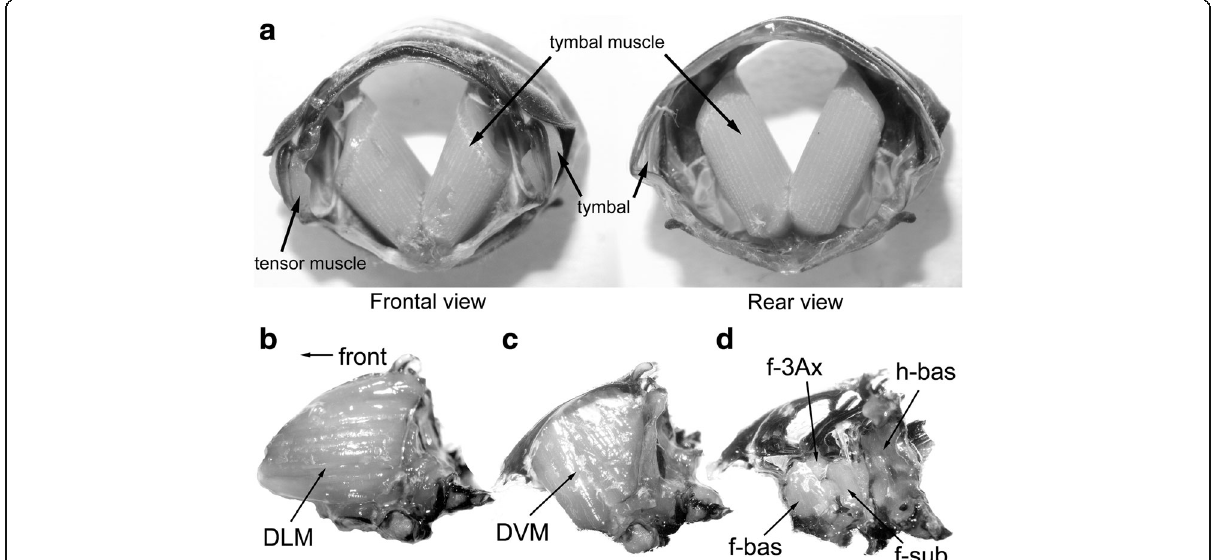
Fig. 1 Photographs tymbal muscles and flight muscles. a tymbal muscles and related structures, housed in the first abdominal segment of Graptopsaltria nigrofuscata . b - d Flight musculature of Meimuna oparifera . The entire thorax is split along the midline and viewed from inside. b When the thorax is split along the midline, the massive dorsal longitudinal muscle (DLM) is observed. c The DLM has been removed to reveal the massive dorso-ventral muscle (DVM). d The DVM has also been removed to reveal the direct flight muscles (only the flight muscles relevant to this paper are annotated). f-bas, forewing basalar; f-3Ax, forewing 3Ax muscle (steering muscle), f-sub, forewing subalar; h-bas, hindwing basalar. The hindwing subalar lies behind the hindwing basalar